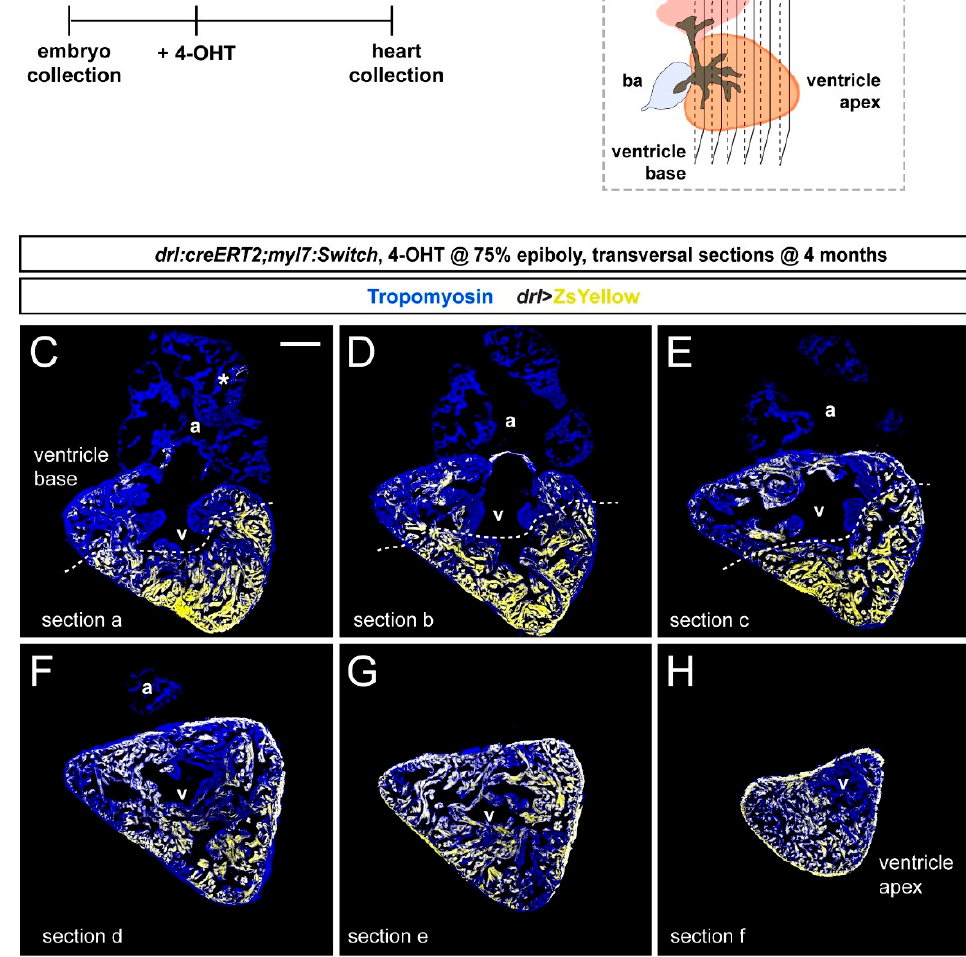
Figure 3. FHF contribution to the adult zebrafish ventricle remains localized. ( A ) Schematic of the experimental design and timeline. Embryos were 4-OHT-treated at 75% epiboly and raised to adulthood for 4 months. ( B ) Hearts were dissected from the adult animals and sequentially sectioned from the base of the heart to the apex as per schematic. ( C – H ) Series of transversal sections of a selected heart, immunostained against Tropomyosin (blue) and showing ZsYellow expression (yellow) from drl:creERT2 -recombined myl7:Switch with atrium (a) on top and ventricle (v) at the bottom. Asterisk denotes rare atrial ZsYellow clones throughout sections. Note the markedly larger area of ZsYellow-labeled cardiomyocytes in the ventricle. Scale bar: 200 µm.